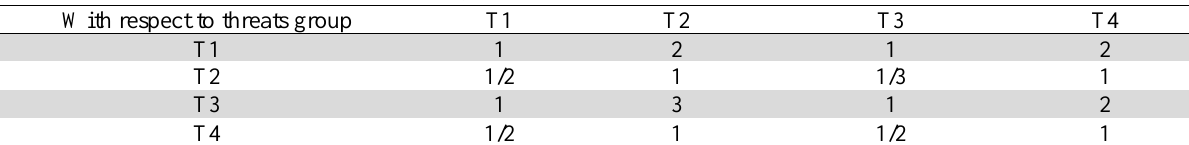
Priorities of threats criteria (CR = 0.8%) With respect to threats